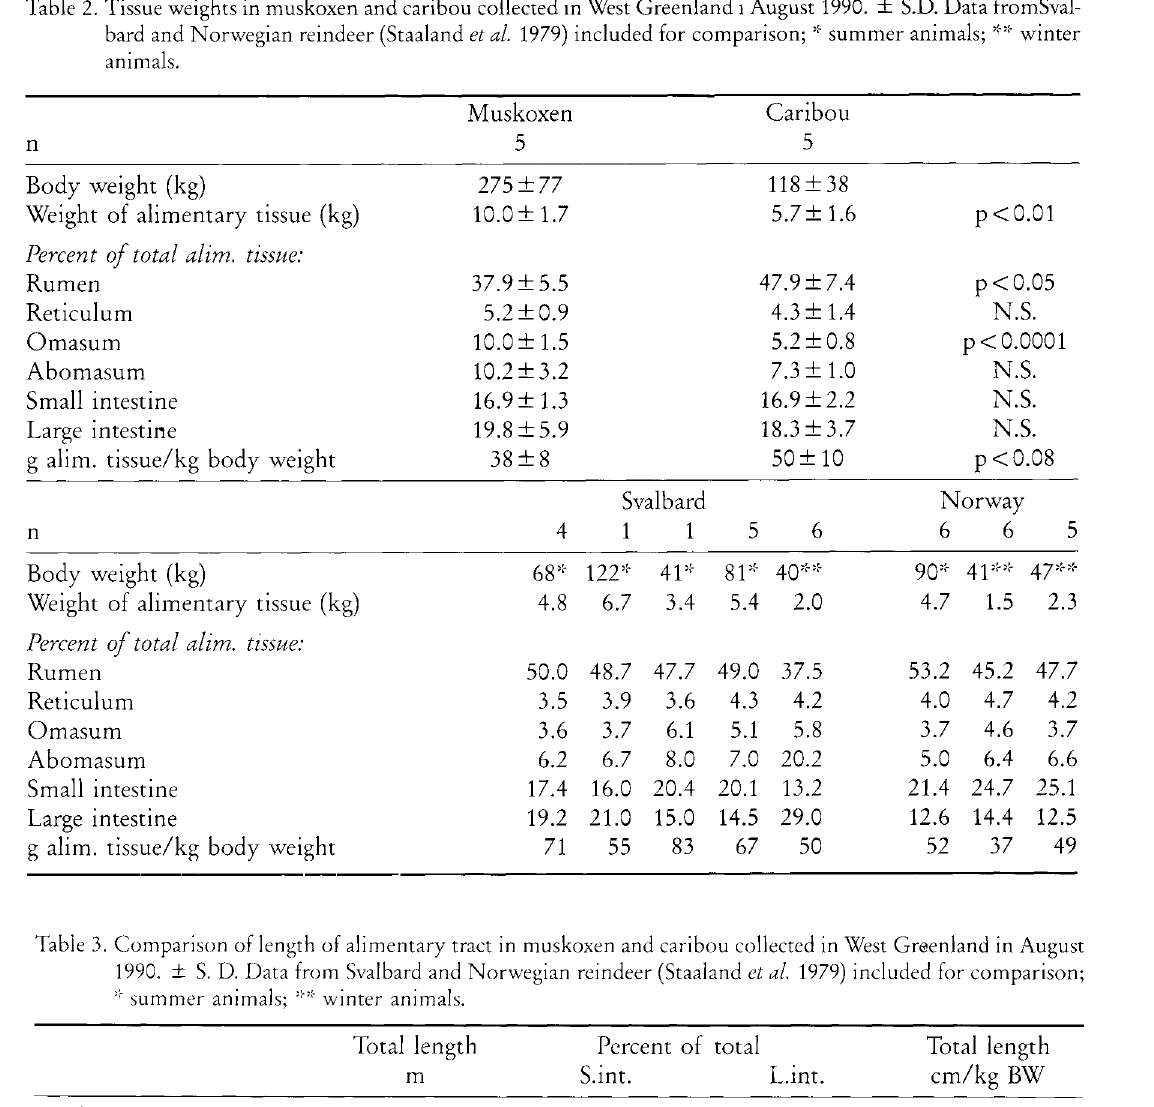
Table 3. Comparison of length of alimentary tract in muskoxen and caribou collected in West Greenland in August 1990. ± S. D. Data from Svalbard and Norwegian reindeer (Staaland et al. 1979) included for comparison; * summer animals; ** winter